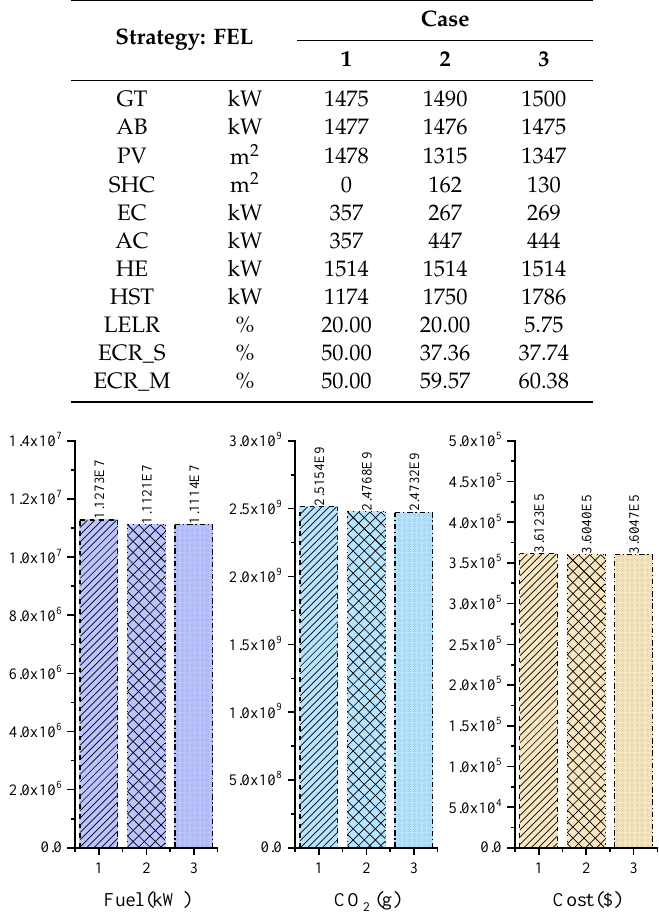
Table 4. Optimal design of deterministic cases in FEL.